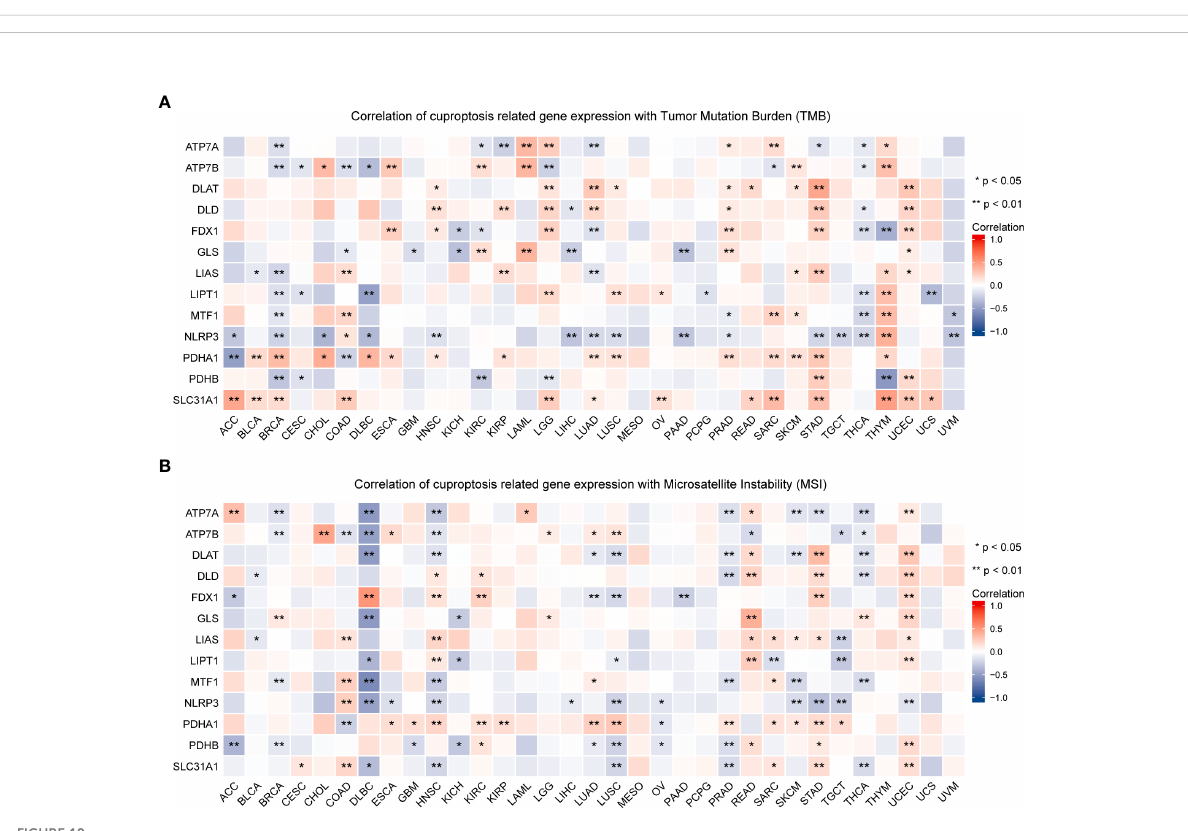
FIGURE 10 Association of the expression of cuproptosis-related genes with TMB (A) and MSI (B) in pan-cancer (*P < 0.05; **P < 0.01). TMB, tumor mutational burden; MSI, microsatellite